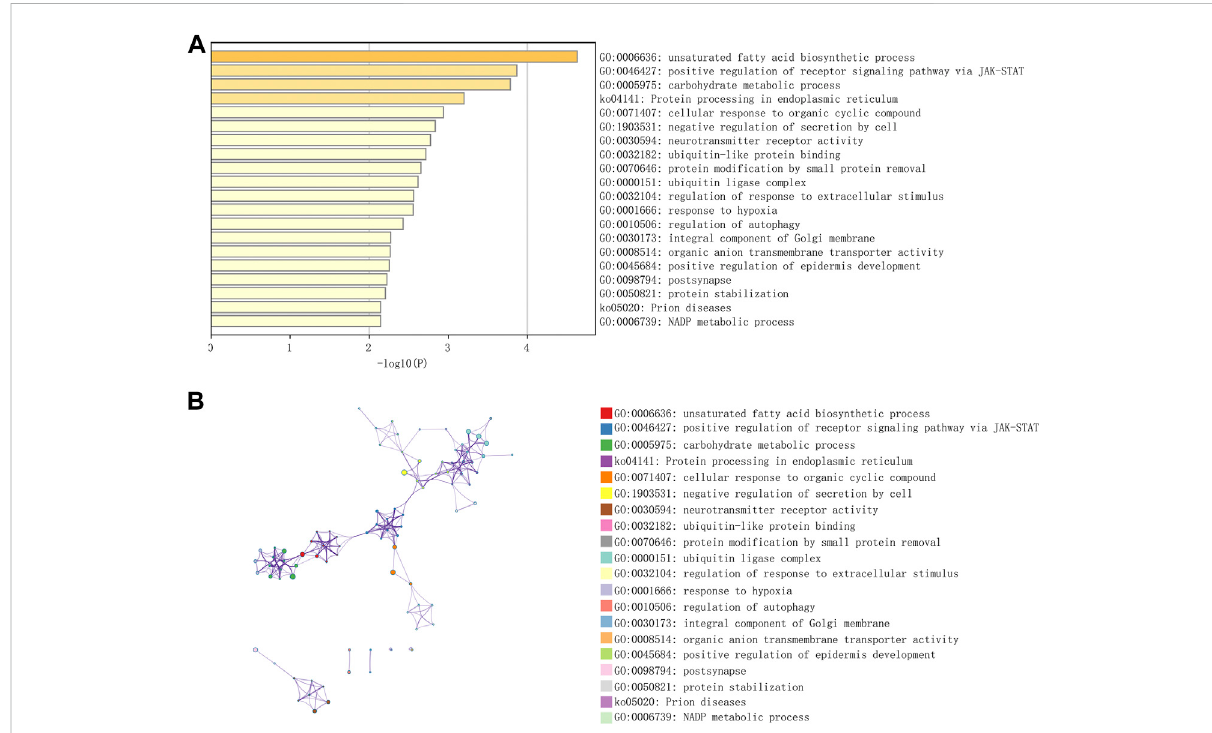
FIGURE 3 Functional enrichment of differential genes in DKD. (A) GO-KEGG enrichment analysis of differential genes from the Metascape database. (B) A cluster network of enriched pathways, in which nodes that share the same cluster are often located close to each